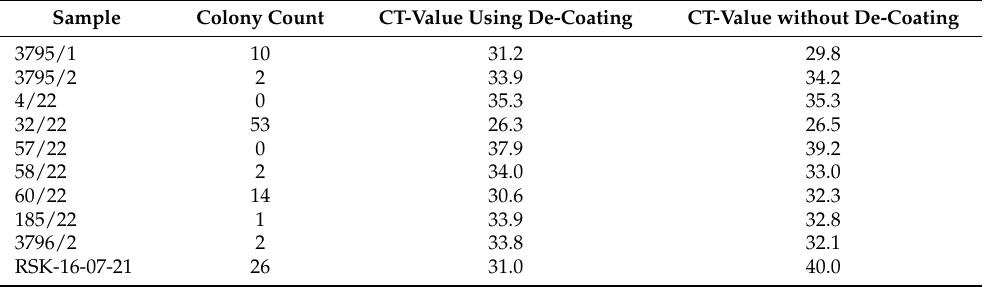
Table 5. Sensitivity and specificity of different CT-values following CT-value limits within the 95% confidence